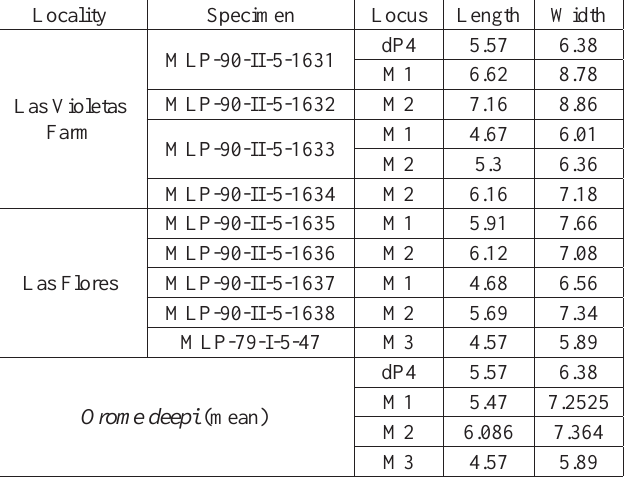
Table 1. Size comparison and mean dimensions (in mm) of Orome deepi gen. et sp. nov. from Las Violetas Farm and Las Flores. Locality Specimen Locus Length